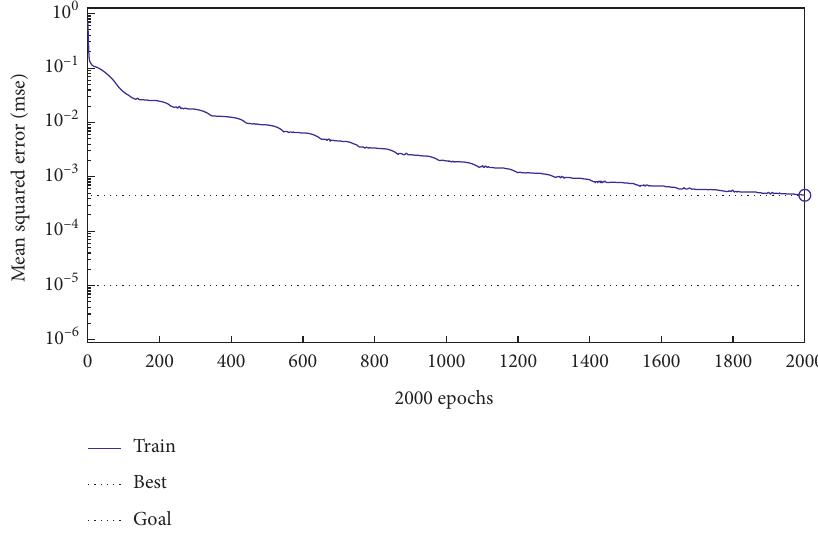
Figure 6: Elman iterative MSE convergence